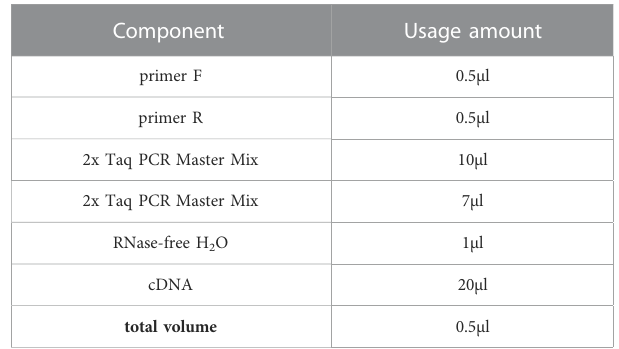
TABLE 2 RT-PCR reaction